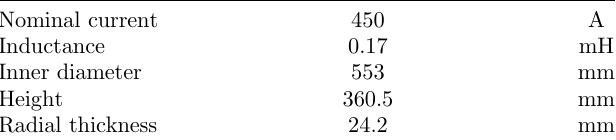
Figure 4. Experimental set-up for Coil55 modal analysis. Table 1. Characteristics of Coil55